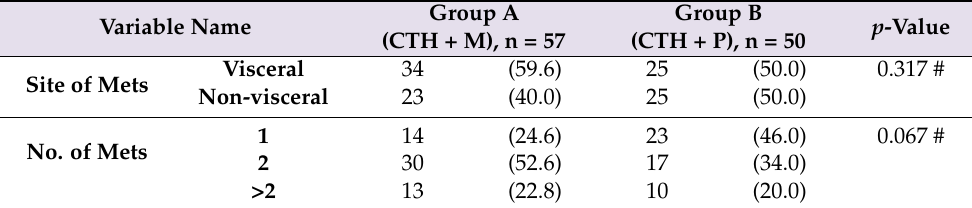
Table 2. Site and number of metastasis, and the initial response of the studied participants (n = 107).